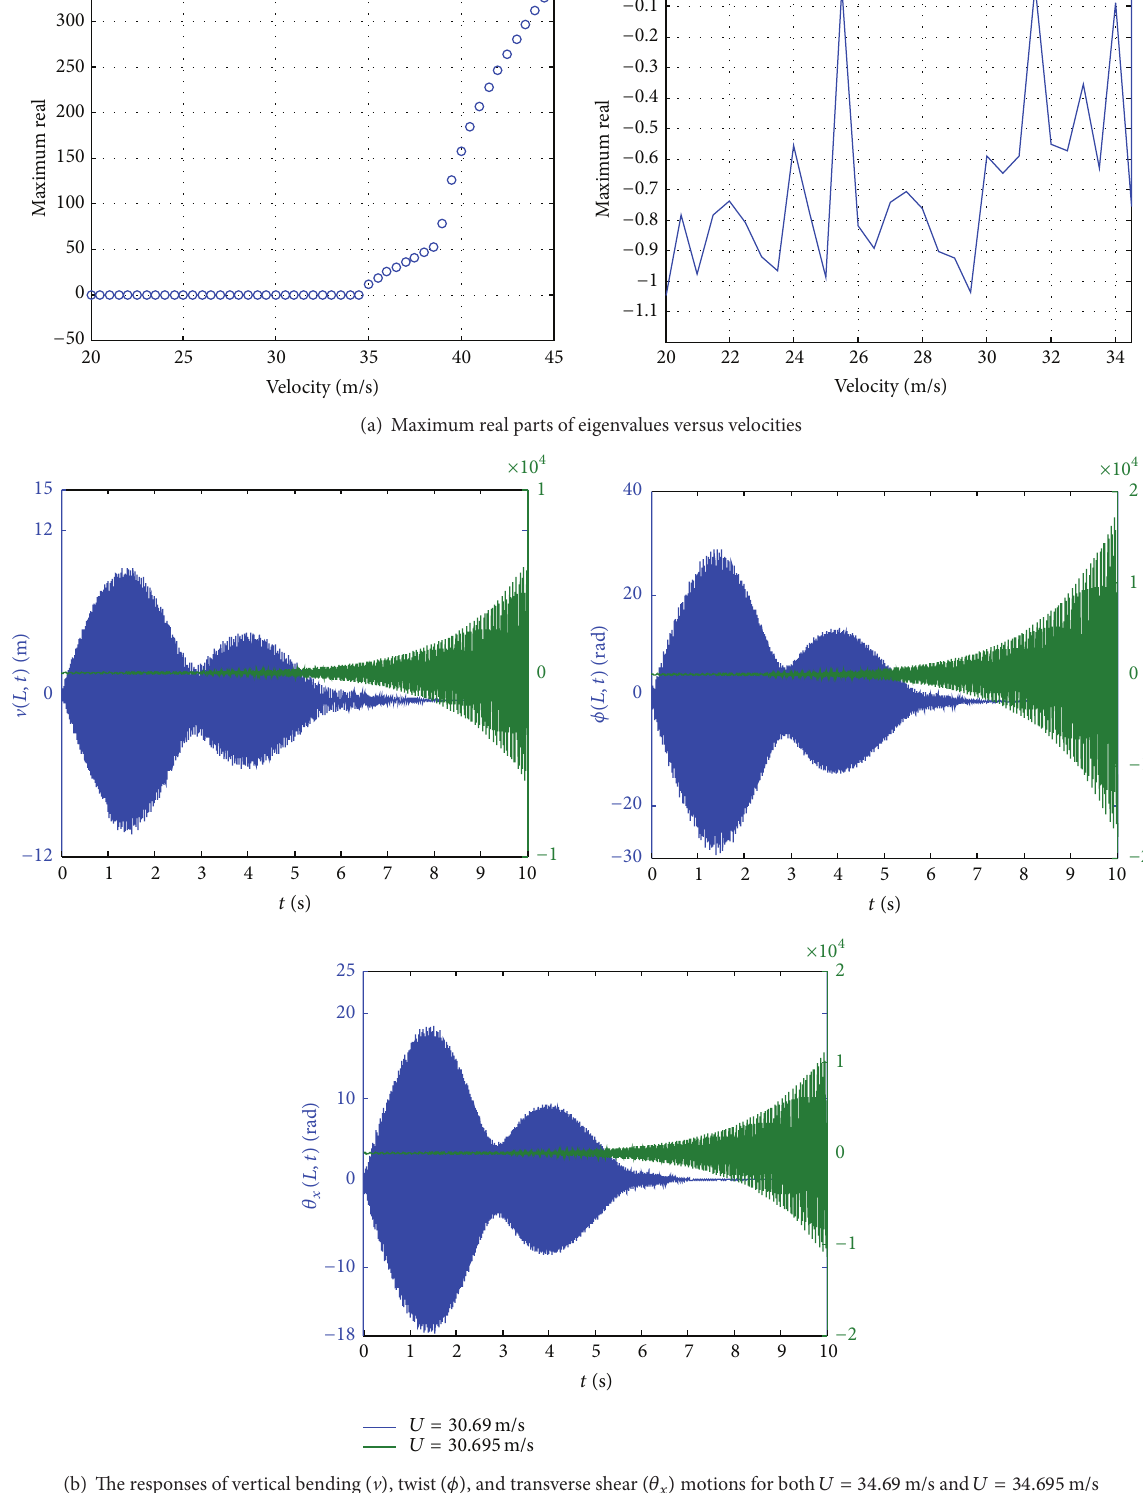
Figure 2: Maximum real parts of eigenvalues versus velocities (a) and the responses for both 𝑈 = 34.69 m/s and 𝑈 = 34.695 m/s under situation of without piezoelectric materials